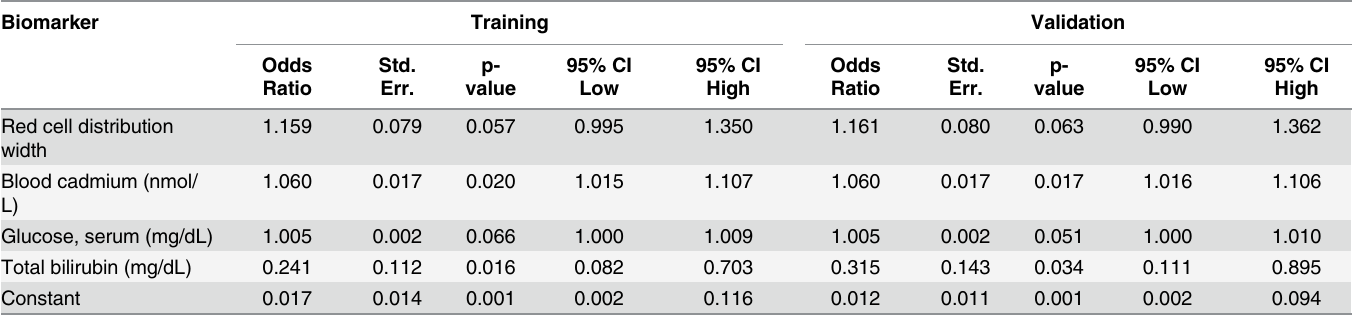
Table 4. Final Four biomarkers from boosted